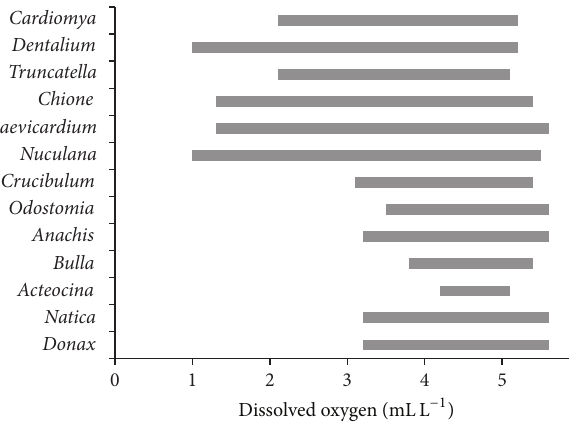
Figure 3: Range of dissolved oxygen concentrations for the thirteen dominant genera of mollusks.